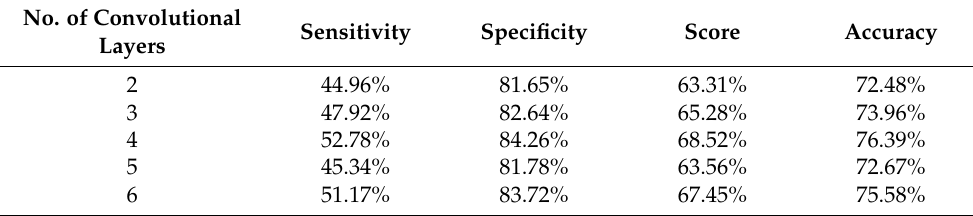
Table 1. Proposed model’s performance for different number of convolutional layers.